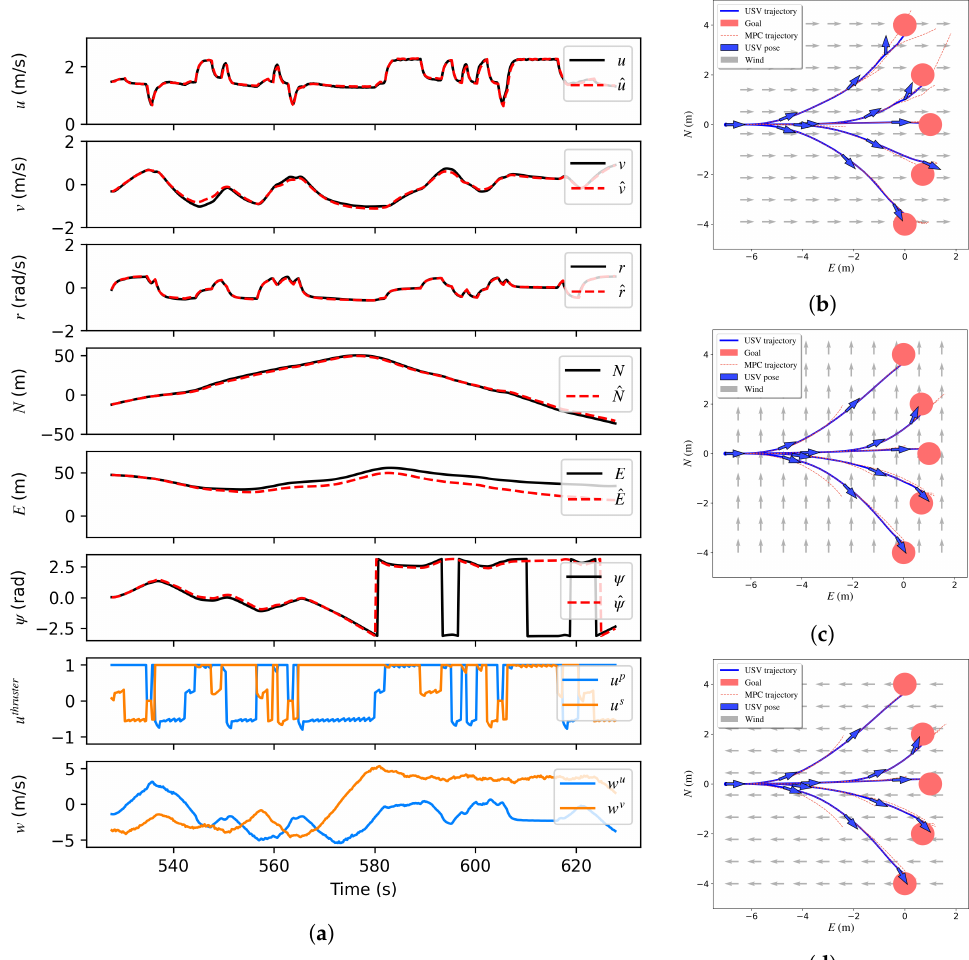
Figure 14. ( a ) is the testing result for the neural network giving initial state and future control inputs and disturbances. The neural network system model is then used by MPC to follow the waypoint under wind disturbance as shown in ( b – d ). The blue curves are the USV’s actual trajectories. The red dashed lines are the trajectories generated by MPC. The red circles are the waypoints generated by the DRL agent. ( a ) Measured output u , v , r (black) and model simulation ˆ u , ˆ v ,ˆ r (red) obtained by the trained neural model. ( b ) Along the wind. ( c ) Perpendicular to the wind. ( d ) Against the